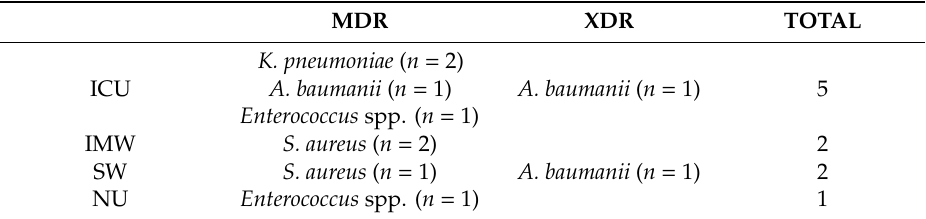
Table 3. Distribution of MDR and XDR Isolates Among the four Departments.